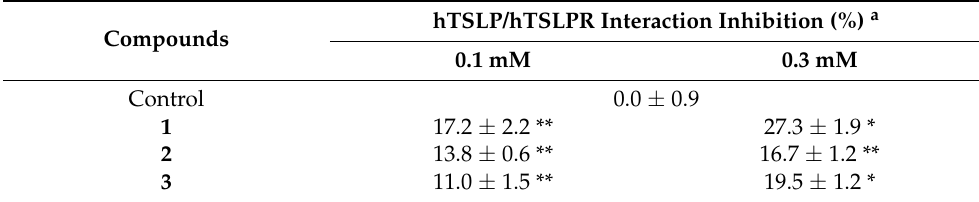
Table 2. The inhibitory effects of isolated compounds 1 – 3 on thymic stromal lymphopoietin (TSLP)/TSLP receptor (TSLPR) interaction by ELISA.